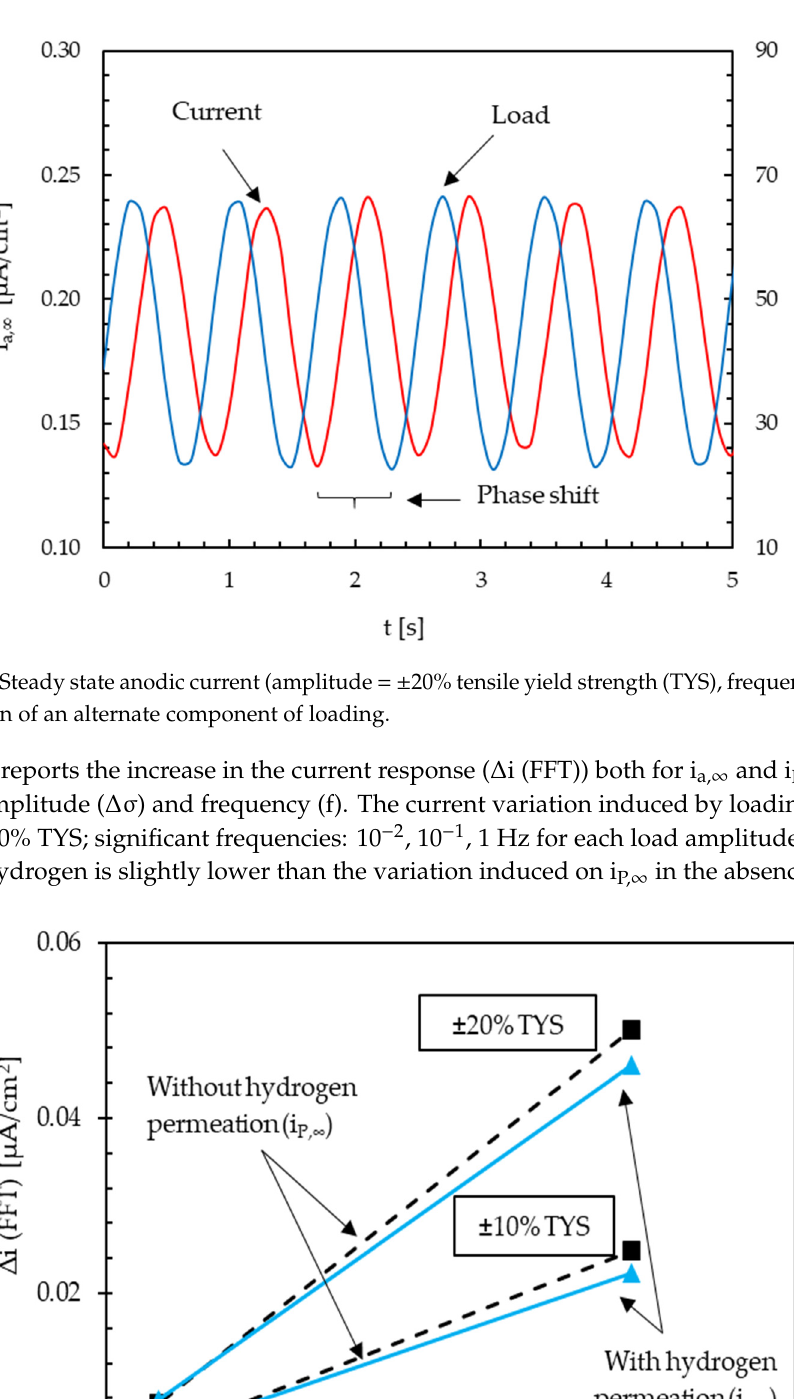
Figure 7. Effect of instant variations of the maximum load (amplitude = ± 10% TYS; frequency = 10 − 2 Hz) on the steady state anodic current (i a, ∞ ). For the loading variation from 0% to 55% TYS, no appreciable variations in the hydrogen flux can be noticed. As loading variations approached the yield limit (from 55% to 90% TYS and from 90% to 100% TYS) and exceeding that limit (from 100% to 110% TYS), an instantaneous peak in the current at the loading variation is detected, and a marked drop to values well below the initial steady state flux is seen. Then, a transient can be evidenced, and the current slowly returns to values approaching the steady state reached prior to the loading variation.